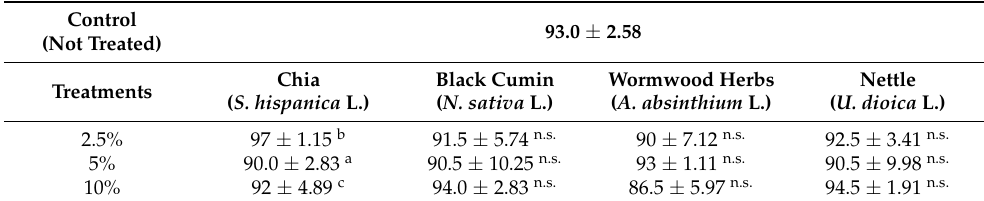
Table 6. Comparison of differences of means for spinach seeds germination ( S. oleracea L.) (The values in the table represent the mean value of germination rate in % ± SD). Control 93.0 ± 2.58 (Not Treated) Chia Black Cumin Wormwood Herbs Treatments ( S. hispanica L.) ( N. sativa L.) ( A. absinthium L.)